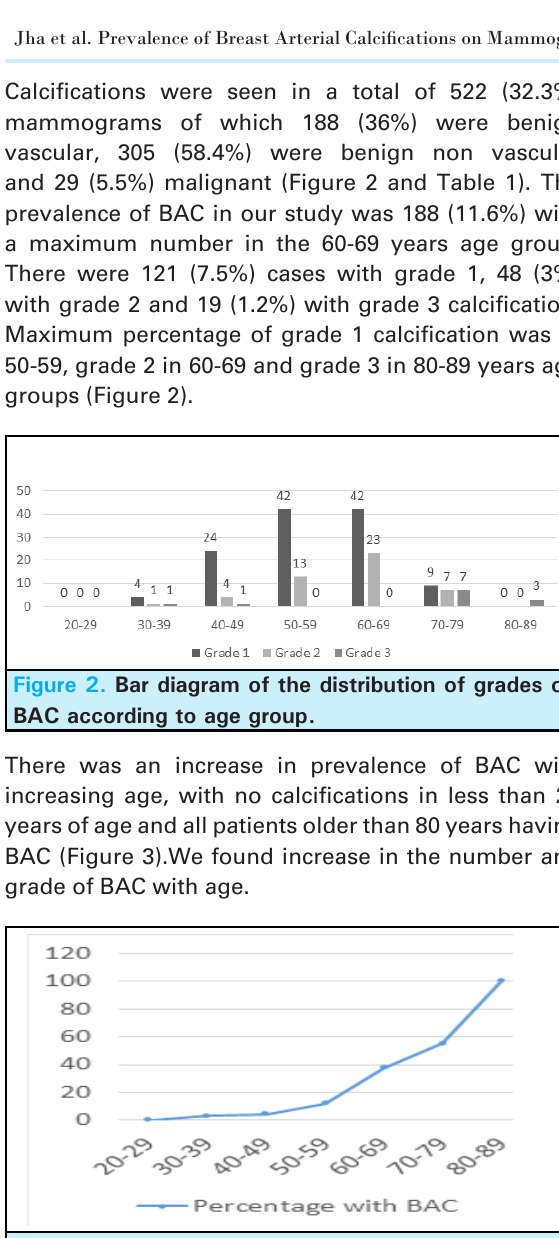
Figure 3. Percentage distribution of BAC with